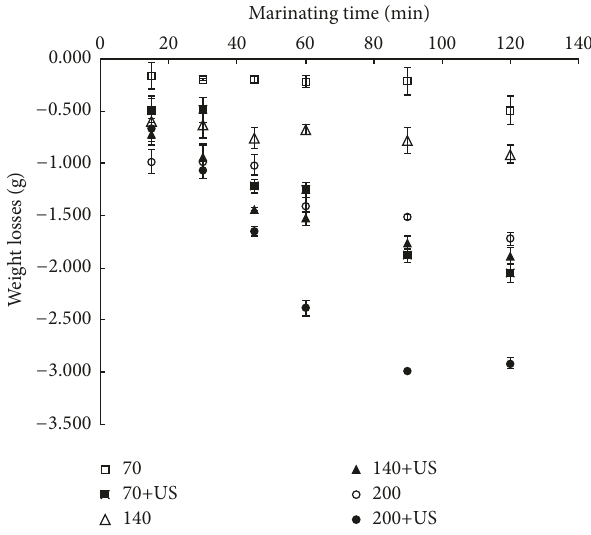
Figure 1: Weight losses during marinating of rabbit meat assisted by power ultrasound or in static bath at different salt concentrations (70, 140, and 200 g NaCl/L).